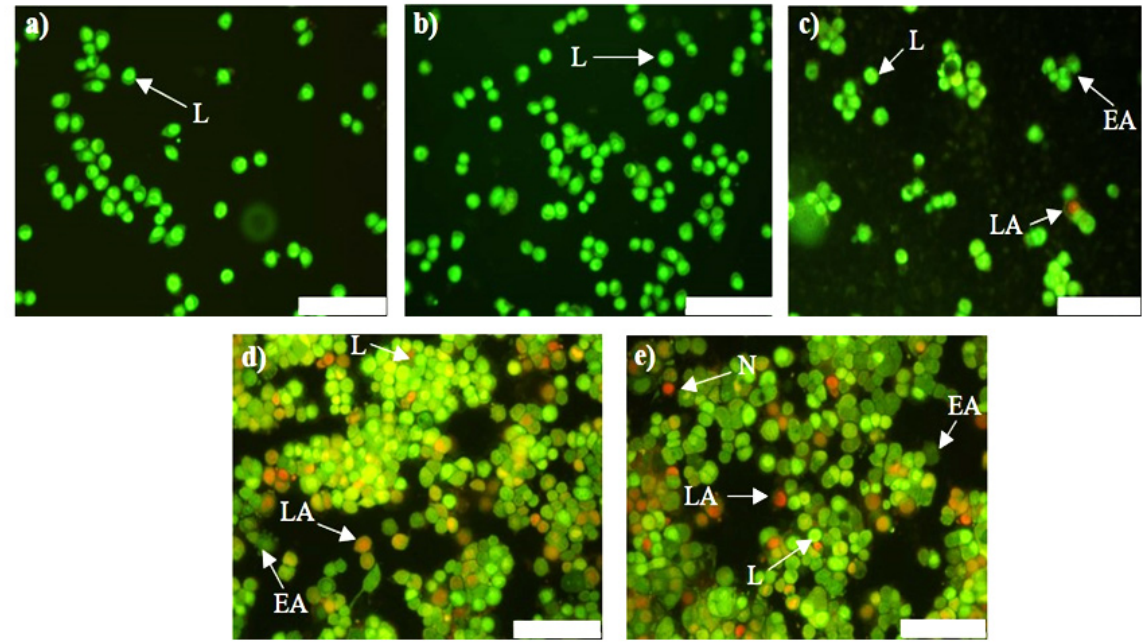
Figure 10. Apoptotic potential of anti- c-myc lipoplexes in HT-29 cells. Cells were visualised 48 h post-transfection with AO/EtBr dual staining. a ) Control, no treatment, ( b ) naked anti- c-myc -siRNA, ( c ) LF3K:siRNA, ( d ) MS09:DOPE:siRNA and e ) MS09:Chol:siRNA. Scale Bar = 100 μm. AO = Acridine Orange, EtBr = Ethidium Bromide, LF3K= Lipofectamine ™ 3000, L= live, EA = early apoptotic, LA = late apoptotic, N = necrotic.